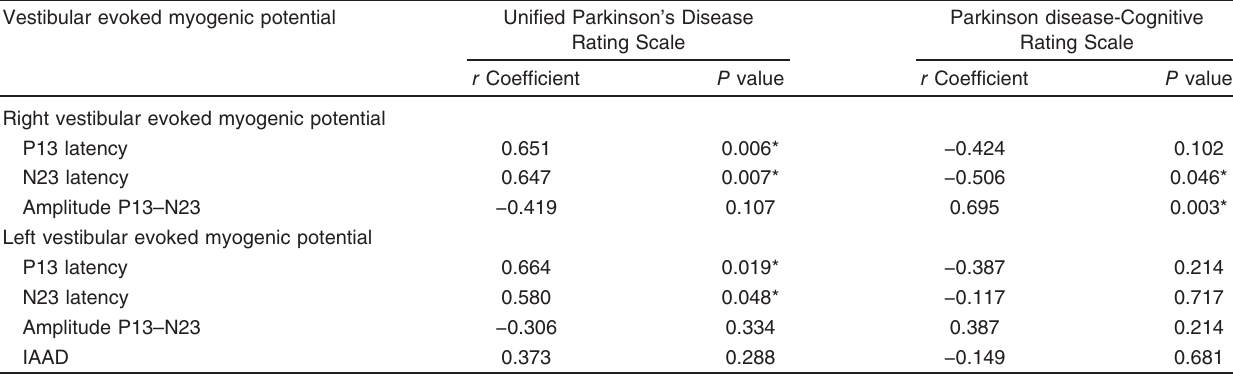
Table 7 Correlation between vestibular evoked myogenic potential parameters and Unified Parkinson ’ s Disease Rating Scale and Parkinson disease-Cognitive Rating Scale in patients with Parkinson disease Vestibular evoked myogenic